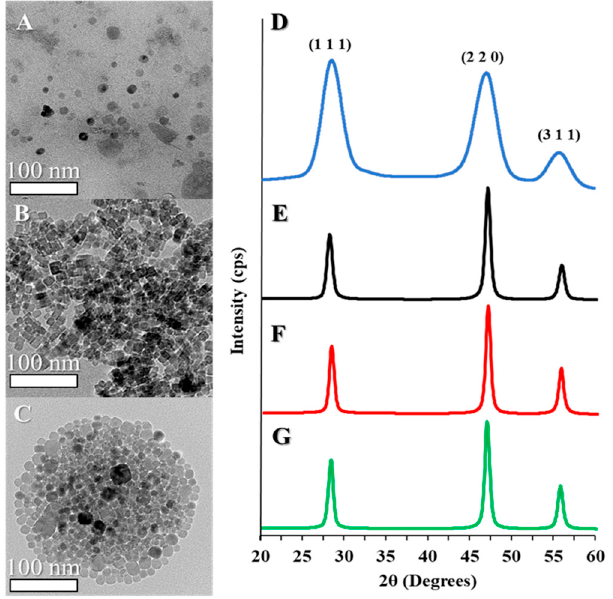
Figure 1. Transmission electron microscopy (TEM) images of: ( A ) CaF 2 nanoparticles (NPs) before and ( B ) after hydrothermal annealing, and ( C ) Tb-doped CaF 2 NPs after hydrothermal annealing. X-ray diffraction (XRD) patterns of CaF 2 NPs ( D ) before and ( E ) after hydrothermal annealing, and ( F ) Eu-doped and ( G ) Tb-doped CaF 2 NPs.